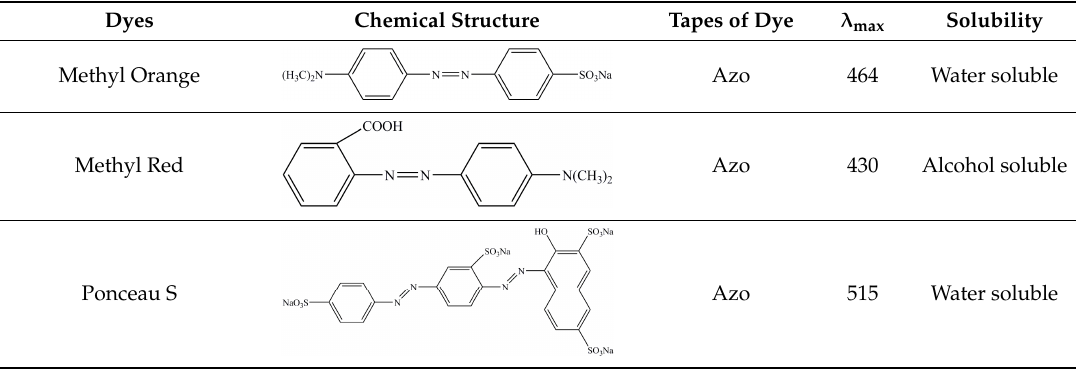
Table 1. Azo, anthraquinone and triphenylmethane dyes used in this study. Dyes